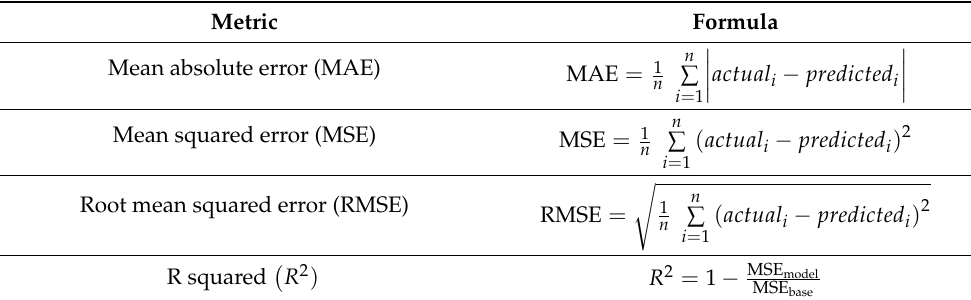
Table 1. Performance evaluation